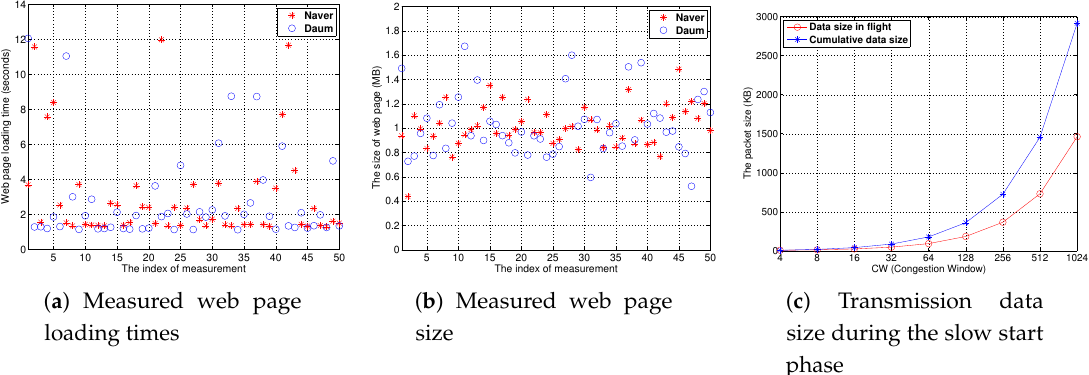
Figure 1. Web page loading times and characteristics of Naver and Daum. ( a ) Measured web page loading times, ( b ) measured web page size and ( c ) transmission data size during the slow start